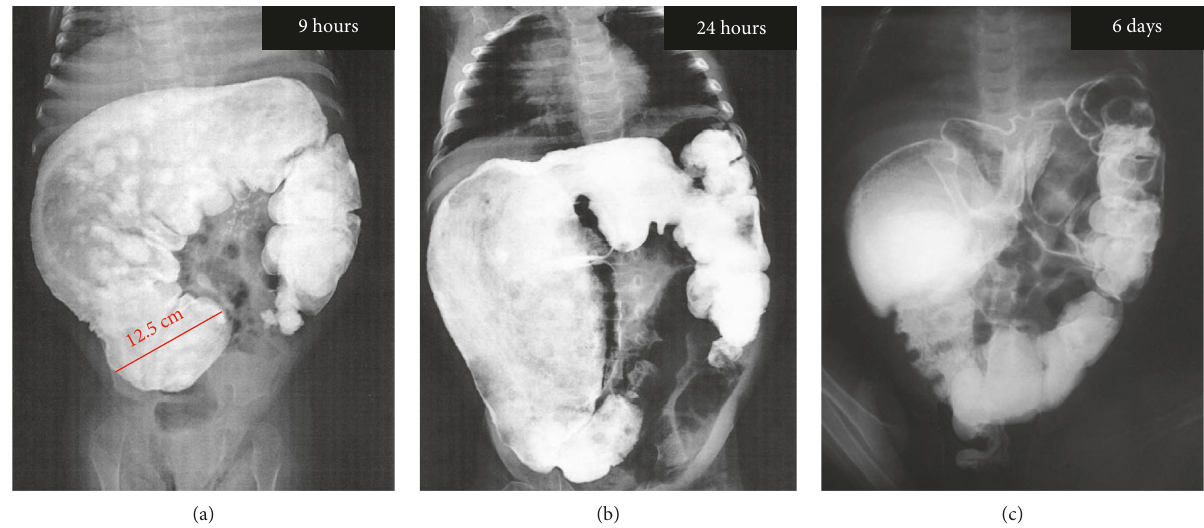
Figure 4: Intestinal transit before levothyroxine sodium replacement therapy, showing a massively dilated stool-filled colon. (a) At 9 hours, an abrupt change between the terminal ileum and cecum occurred, which showed a marked distention, reaching a diameter of 12.5 cm. A massive dilatation of the colon. (b) At 24 hours, contrast persists from cecum to splenic flexure in a dilated colon. (c) After six days, contrast finally reaches sigmoid and rectum, only after a colonic